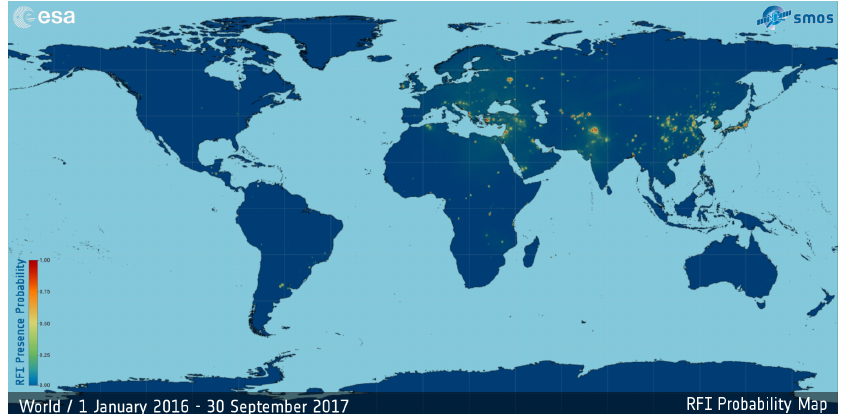
Figure 9. SMOS Radio Frequency Interference (RFI) probability map in the period 1 January 2016 and 30 June 2017 computed following the procedure detailed in